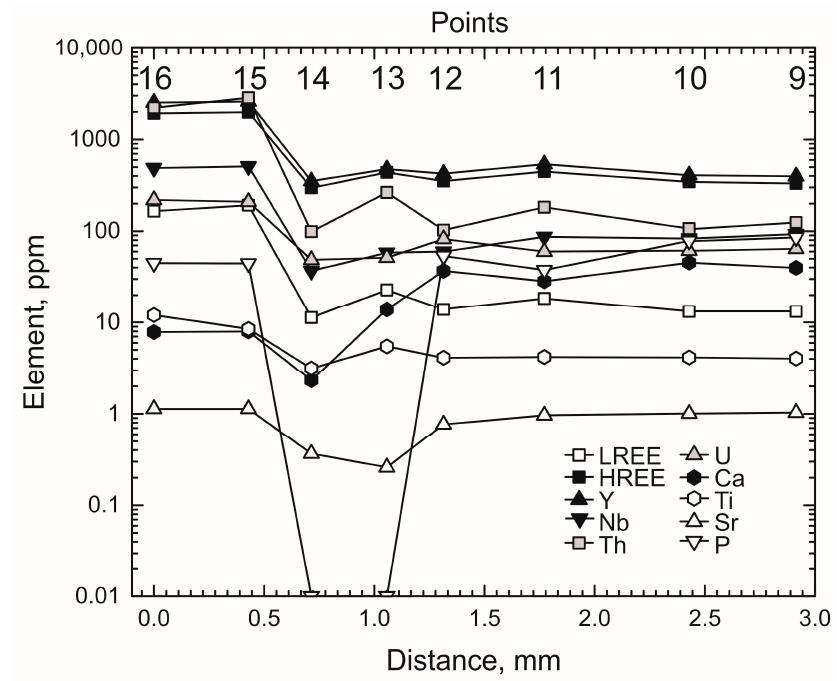
Figure 10. Trace elements zoning of zircon in the growth sector of the prism. Within the face (111) of the dipyramid, the profile discussed consists of seven points (29–24). All the points, except for the fifth from the center of the crystal (point 25–2 in the light band), are in dark zircon (Figure 2). At point 25–2 REE, Y, Nb, Th, and U concentrations increase considerably and also rise gradually at point 26 (Figure 11).